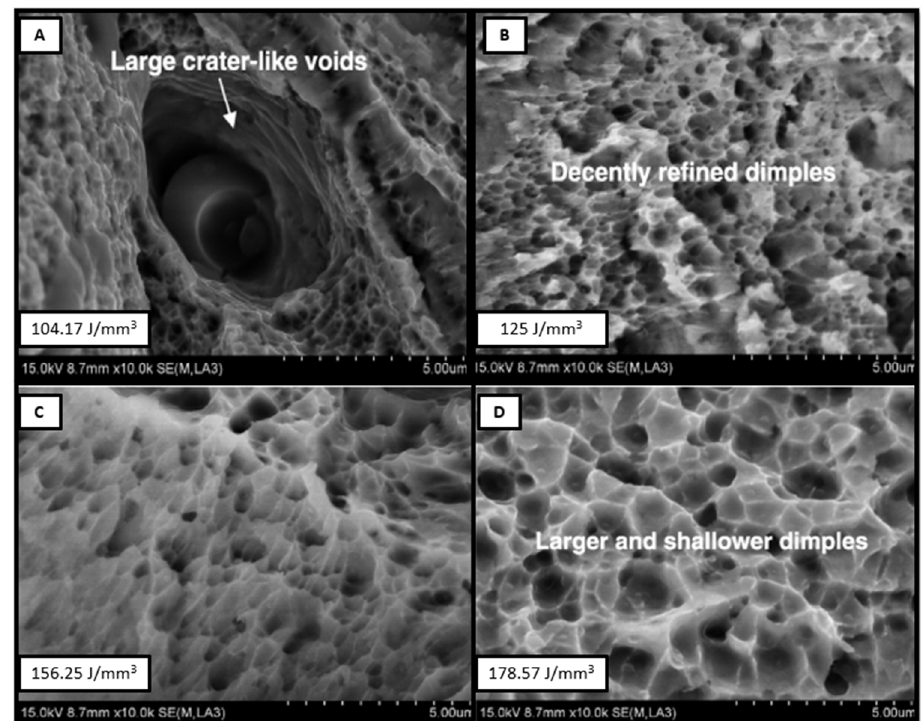
Figure 2. Fracture morphology at different energy densities ( A ) 104.17, ( B ) 125, ( C ) 156.25 ( D ) 178.57 J/mm 3 [4].